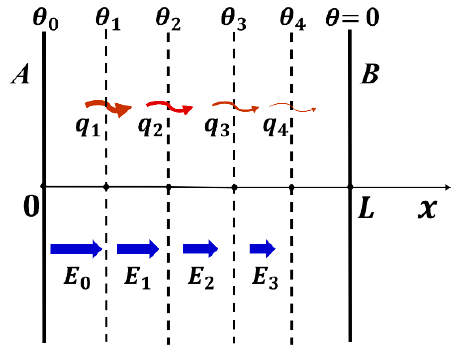
Figure 9. 1D thermal conduction model of a ferroelectric under open-circuit condition.